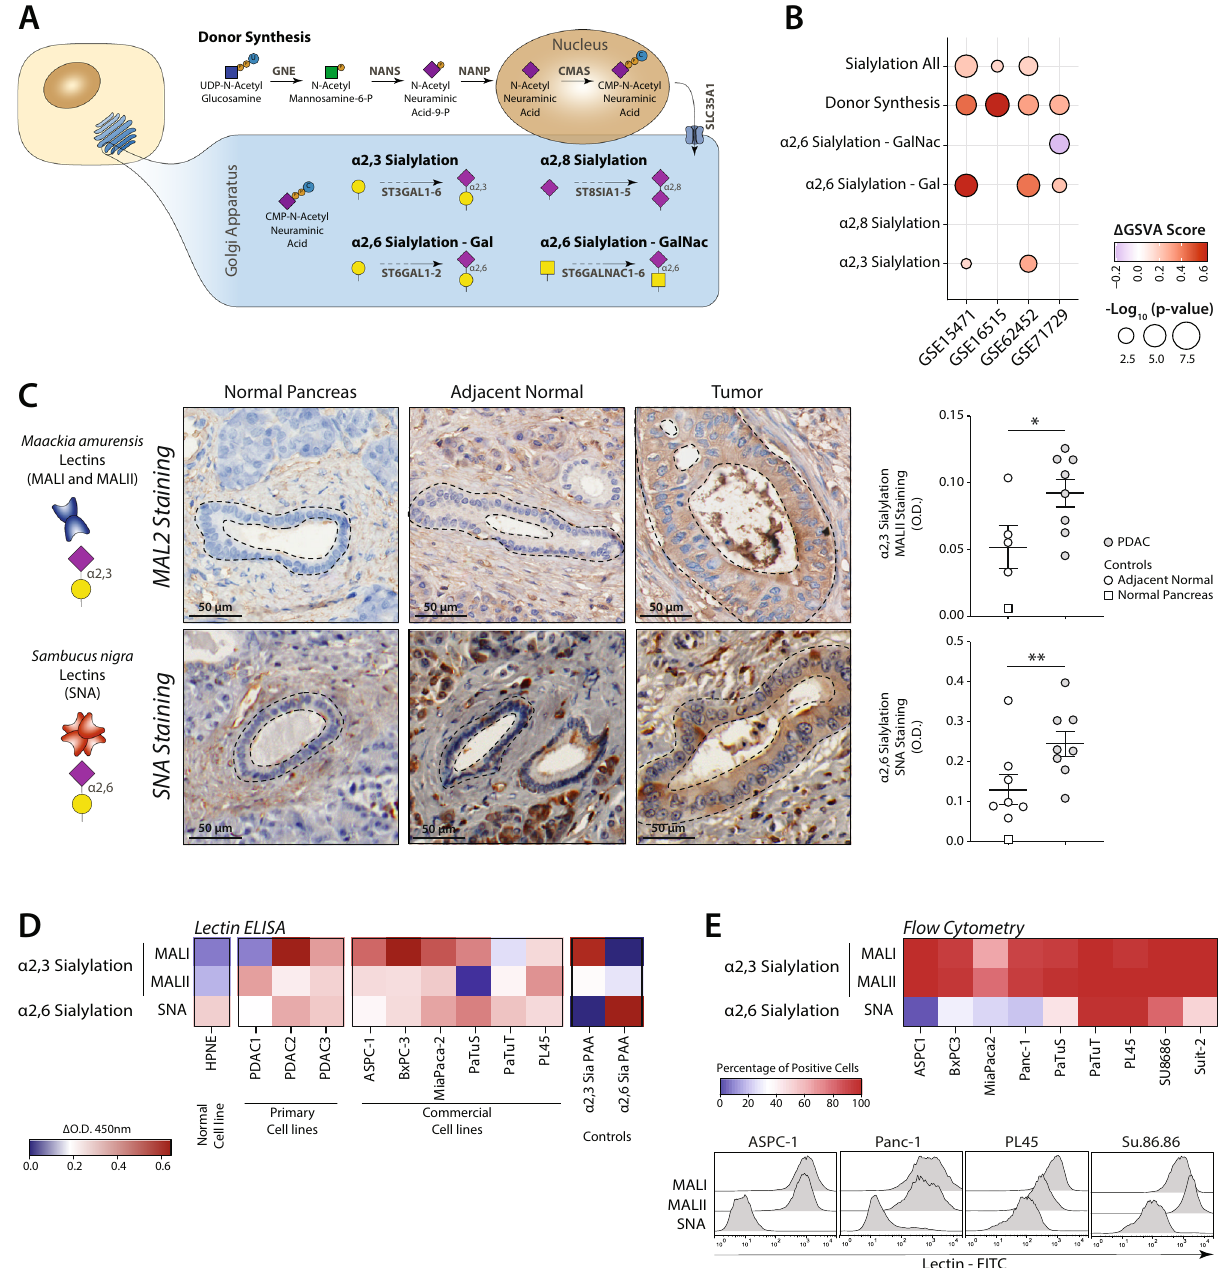
Fig. 1 Sialylation is increased in pancreatic ductal adenocarcinoma (PDAC). A Representation of the different pathways that contribute to sialylation of glycans. B Gene set enrichment analysis of the pathways described in ( A ) in normal and tumour tissue. Δ GSVA score was calculated as the difference between the GSVA score in tumour and in normal tissue. C Immunohistochemistry analysis of the expression of sialylated glycans in normal and tumour tissue, using plant lectins speci fi c for α 2,3 (MAL I and MAL II) and α 2,6 sialic acid (SNA). Data presented as mean values ± SEM. D – E Evaluation of sialic acid expression in PDAC cell lines by ( D ) ELISA and ( E ) fl ow cytometry. Δ D.O. at 450 nm was calculated as the difference of the O.D at 450 nm of the sample and the one of the uncoated ductal cells, which is not the case for α 2,6 sialic acids, we focussed on regulation and recognition of α 2,3 sialylated structures.